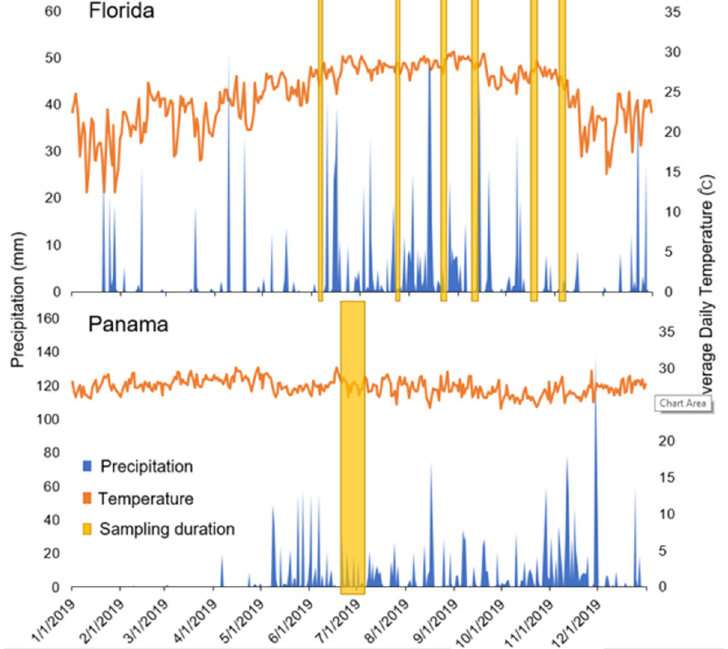
Fig 3. Weather data during 2019 for Florida and Panama, including precipitation (blue) and temperature (orange). Mosquito sampling periods are highlighted in yellow Panama data is from ETESA and Florida data is from NOAA.